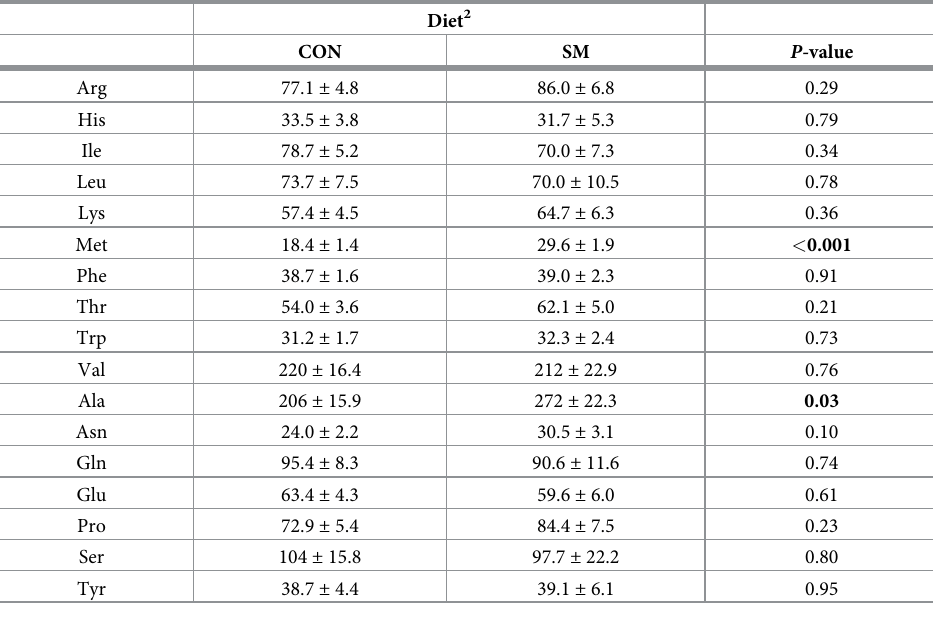
Table 4. Effect of dietary RPMet supplementation on plasma AA concentrations ( μ M) of dairy cows 1